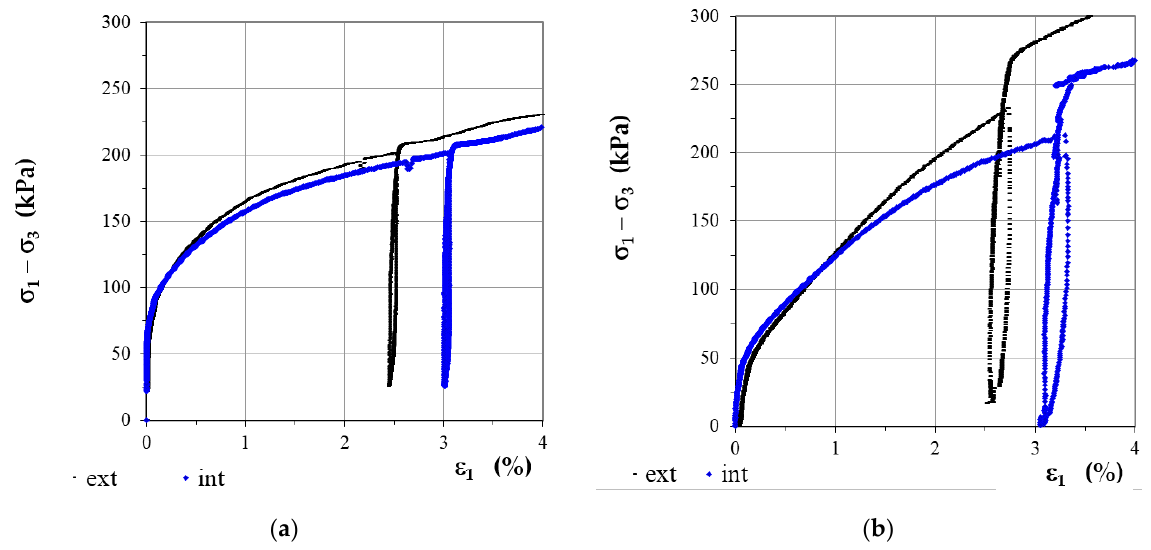
Figure 1. Comparison of the “stress-strain” characteristics in triaxial tests on clay for external (ext) and internal (int) measurement of deformation: ( a ) in undrained conditions; ( b ) in drained conditions; (after [2], via 2020 Creative Commons Attribution-NonCommercial-NoDerivatives 4.0 International Public License).